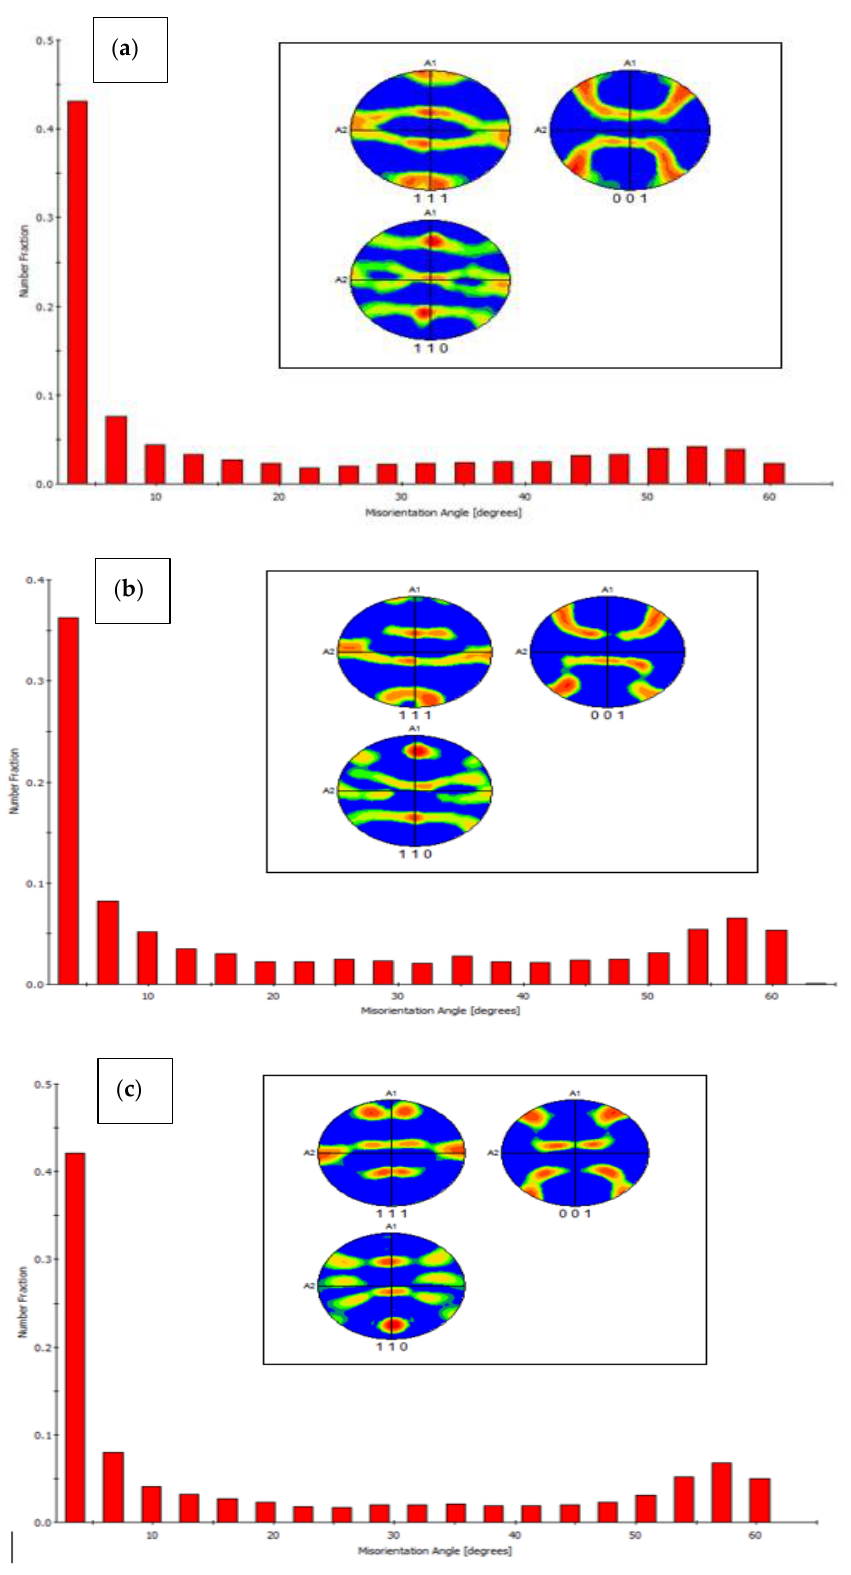
Figure 15. EBSD grain misorientation angle and pole figure of Hot extruded composite plates ( a ) AA 2024 – 2 wt% Graphene composites ( b ) AA 6061 – 2 wt% Graphene composites ( c ) AA 7075 – 2 wt% Graphene composite.